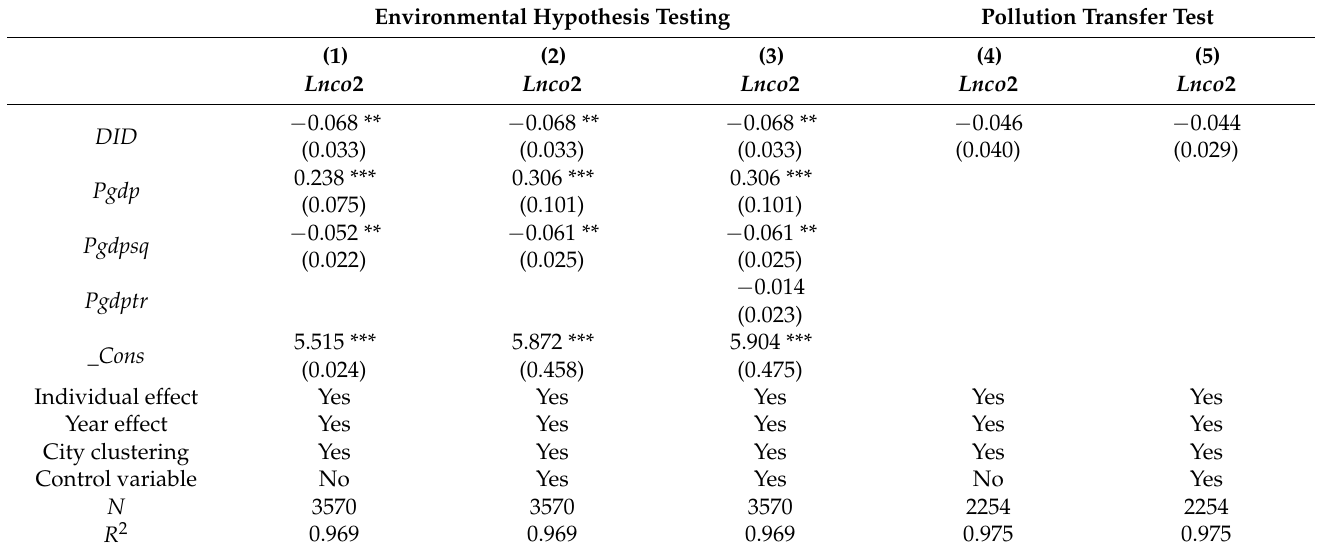
Table 6. Environmental hypothesis testing and evidence of contamination